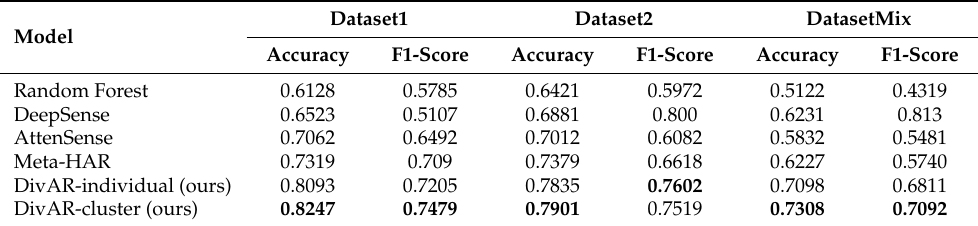
Table 5. Performance (Accuracy and F 1 score ) of baseline method and DivAR on adapting to a new user on three datasets.